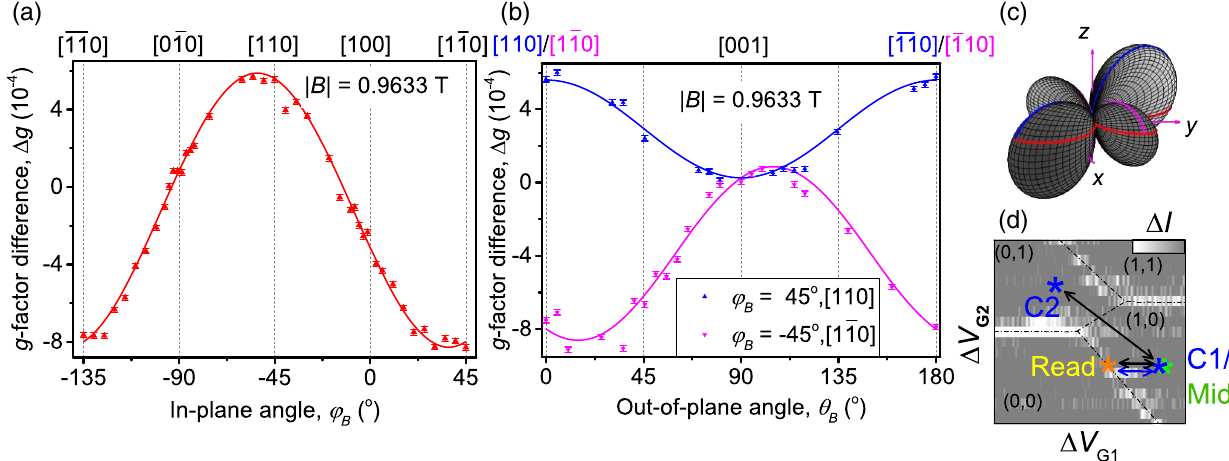
FIG. 2. The g -factor difference between the dots. (a) Difference of g -factors between the dots under G1 and G2 with occupation (1,0) and (0,1) as a function of in-plane magnetic field angle, together with sinusoidal fit. (b) Difference of g -factors between the dots under 1¯10 G1 and G2 as a function of out-of-plane magnetic field angle along [110] (blue) and [ ] (magenta). (c) Isosurface representation of the absolute value of g -factor difference as a function of magnetic field orientation. The magenta arrows represent crystal lattice orientation. The red, blue, and magenta curves correspond to the fits in panels (a) and (b). (d) Pulse sequences (black and blue arrows) used to measure the g -factor difference in panels (a) and (b). C1 and C2 indicate the two different control points in the two different